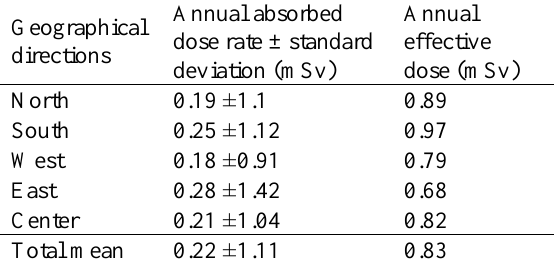
Table 4. Total mean absorbed dose rate and annual effective dose received by public school students in Hamadan based on total open and closed spaces as separated by geographical direction 13 Geographical